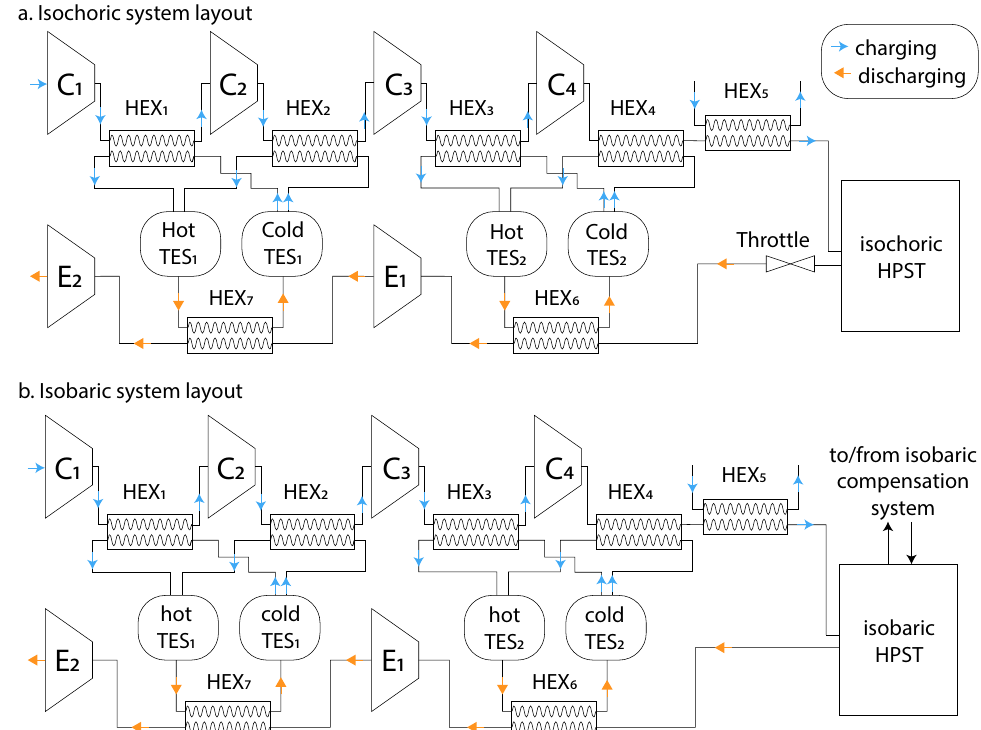
Figure 2. Schematic diagram of the ACAES systems. ( a ) Isochoric—the air leaving the HPST is throttled to the minimum storage pressure. ( b ) Isobaric air storage is maintained so no throttle is